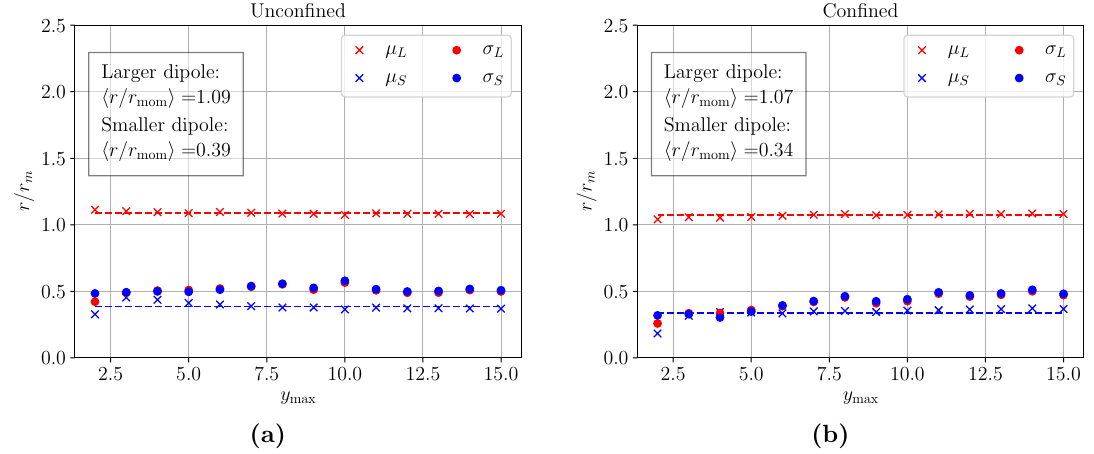
Figure 4. The scaled lengths of the daughter dipoles w.r.t. the mother dipole as a function of maximal rapidity for uncon(cid:12)ned (a) and con(cid:12)ned (b) dipole-evolution. The parameters used in the dipole evolution are the same as presented in table 1.